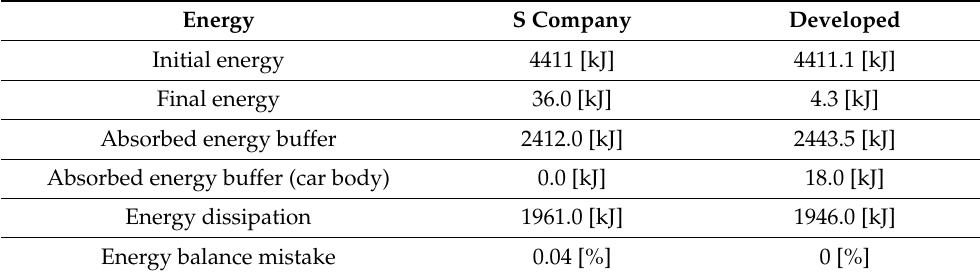
Table 2. Comparison of energy balance during collision.